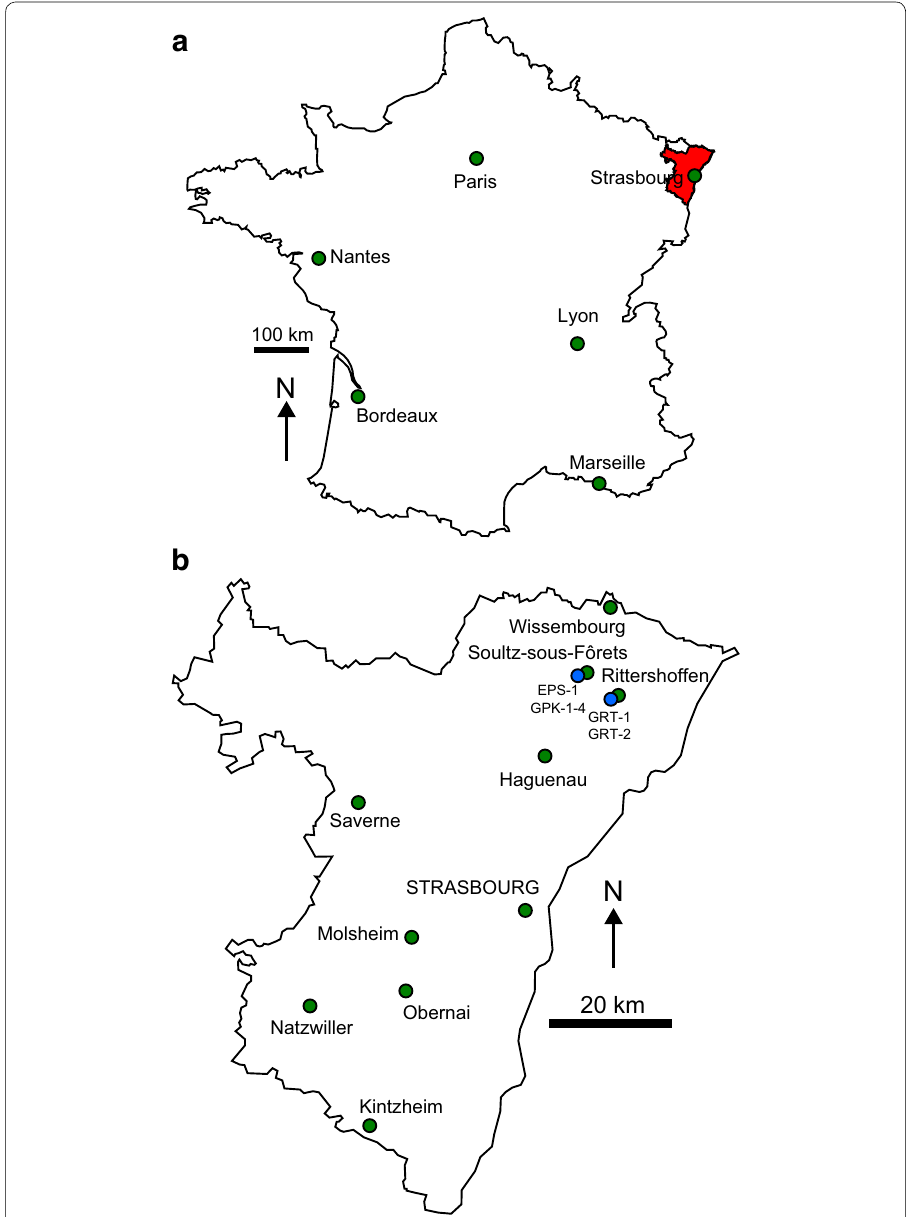
Fig. 1 a Map of France showing the location of the Bas-Rhin (Lower Rhine) department of Alsace (in red). b Map of the Bas-Rhin department of Alsace (shown in red in a ) showing the location of the major cities/towns and the geothermal sites and geothermal boreholes of Soultz-sous-Forêts and Rittershoffen (Figure modified from Heap et al.